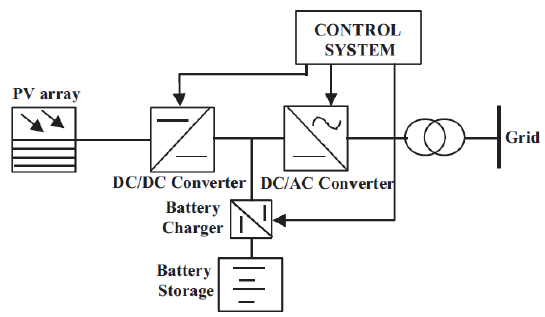
Figure 3. Grid ‐ connected SPVGP structure.